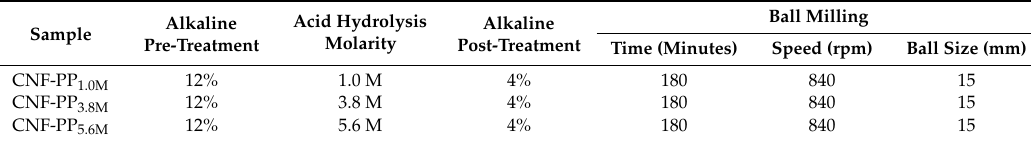
Table 1. Selected processing parameters for the synthesis of cellulose nanofibers (CNFs) from Napier fibers. Acid Hydrolysis Alkaline Alkaline Sample Molarity Pre-Treatment